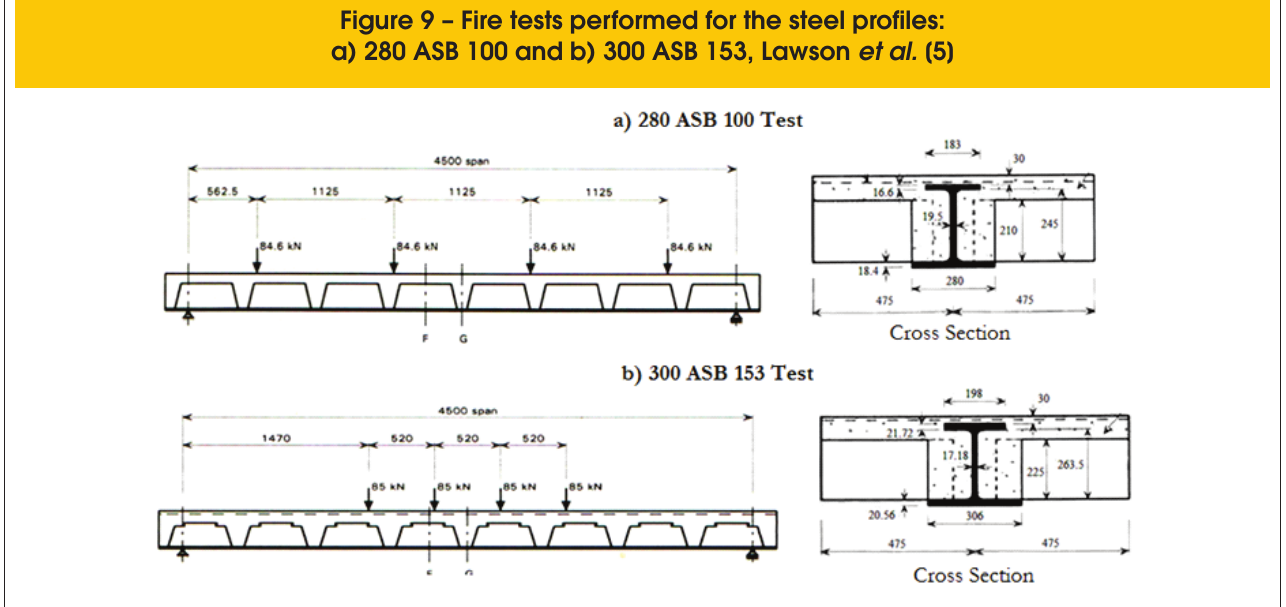
Figure 9 – Fire tests performed for the steel